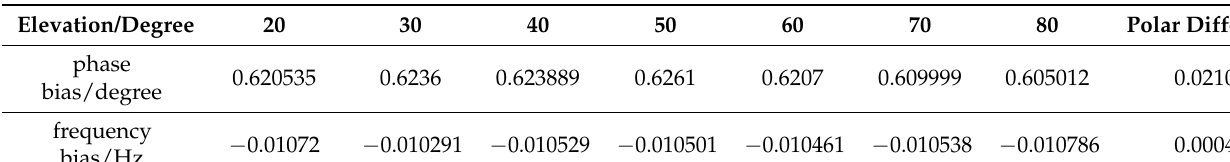
Table 4. Carrier characteristic bias for BDS3 prn 21.